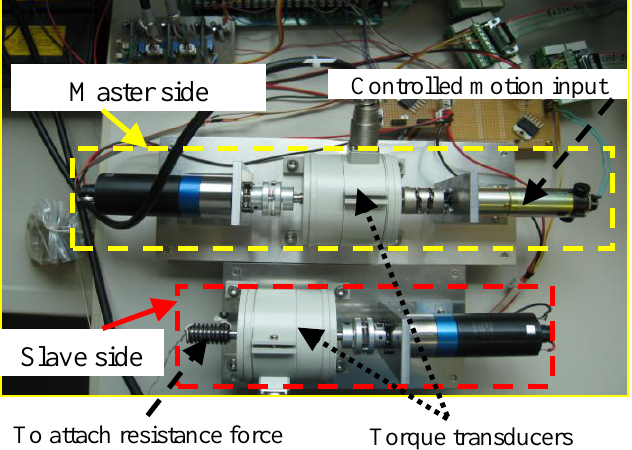
Figure 3. The experimental platform to test the force sensing mechanism in a master-slave